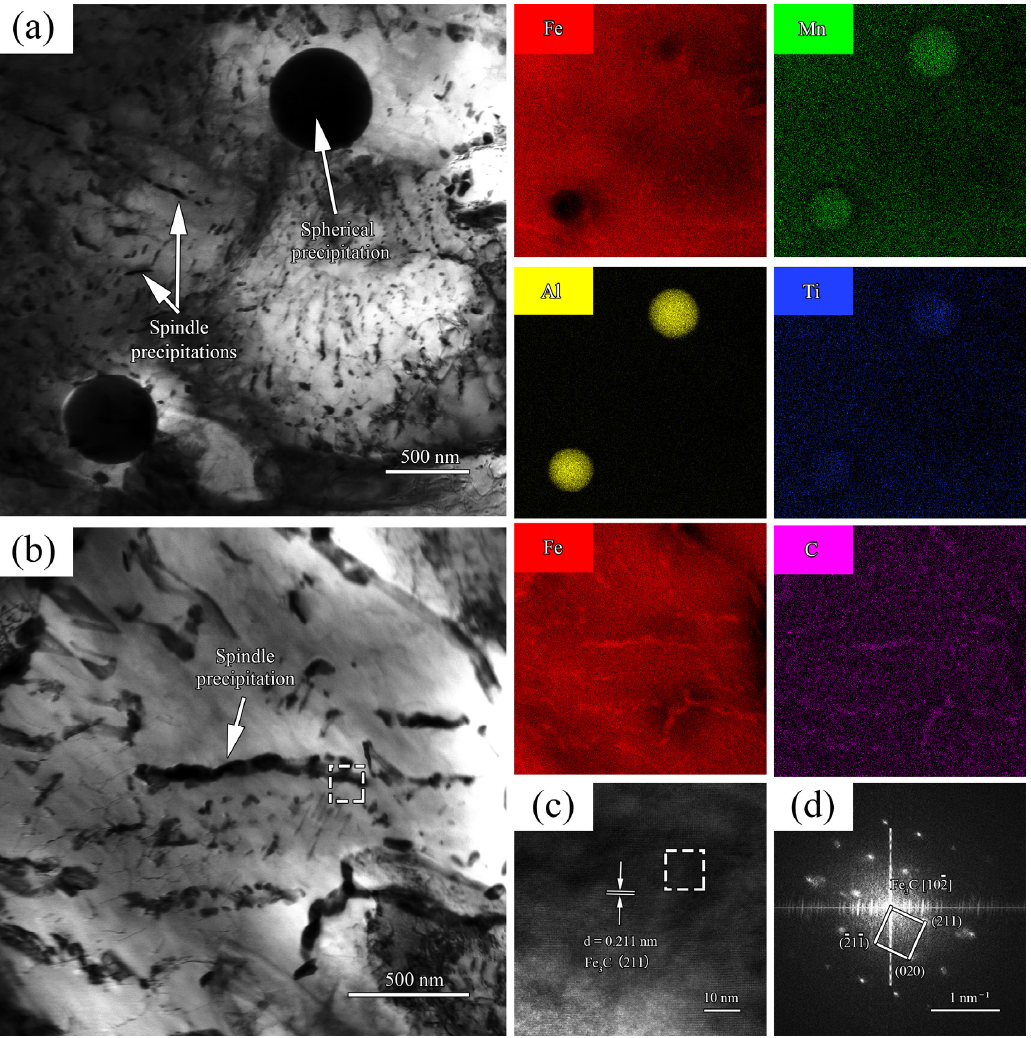
Figure 13. Morphology of precipitations and elements distribution of sample 2: ( a ) spherical precipitations and relevant elements distribution; ( b ) spindle precipitations and relevant elements distribution; ( c ) HRTEM image of the white square marked precipitation; and ( d ) corresponding FFT pattern of HRTEM.